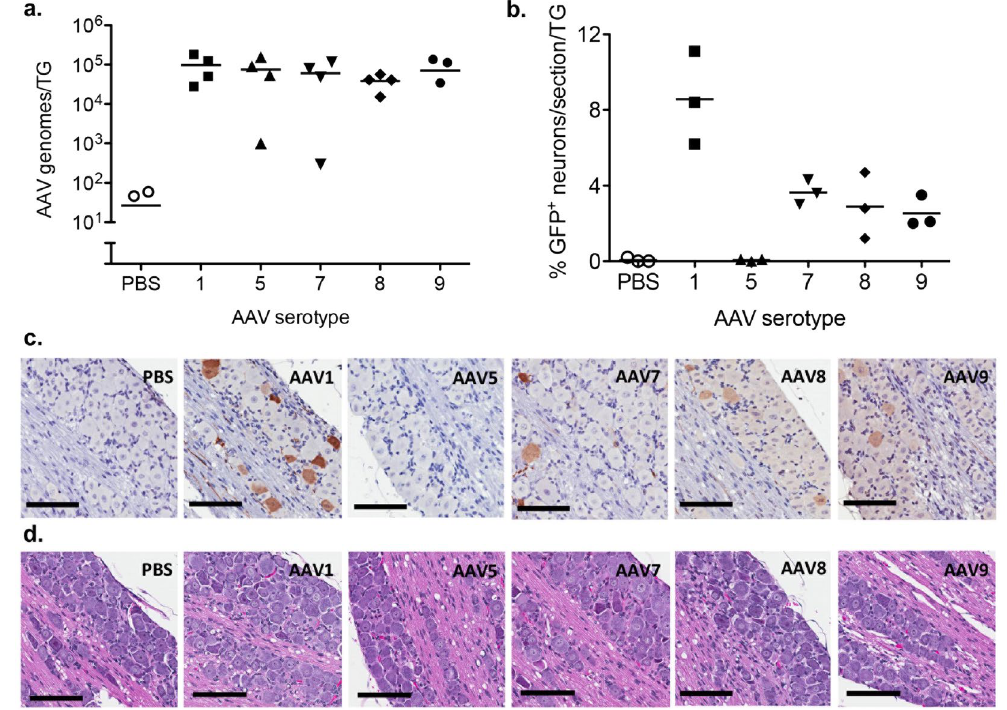
Figure 2. Comparison of AAV serotypes for gene delivery to trigeminal ganglia. Swiss Webster mice were inoculated by intradermal injection of the whiskerpad with PBS or scAAV-smCBA-GFP vectors packaged into AAV serotypes 1, 5, 7, 8 or 9 at a dose of 1 × 10 11 vector genomes per whiskerpad. ( a ) At 7 days post AAV delivery DNA was isolated from trigeminal ganglia and total levels of AAV vector genomes per ganglion were quantified by qPCR. Each symbol represents one trigeminal ganglion (TG) from a total of either 2 animals for each AAV serotype or 1 animal for PBS control. ( b ) At 14 days post AAV delivery the percentage of neurons positive for mCherry by immunohistochemistry were quantified in trigeminal ganglia using Cell Profiler software. Each symbol represents the average number of GFP positive neurons from 2 sections of an individual trigeminal ganglion from 3 different animals for each AAV serotype and PBS control. ( c ) Immunohistochemical detection of GFP and ( d ) hematoxylin/eosin staining of representative sections from trigeminal ganglia harvested at 14 days post AAV delivery. Scale bar: 100 μ